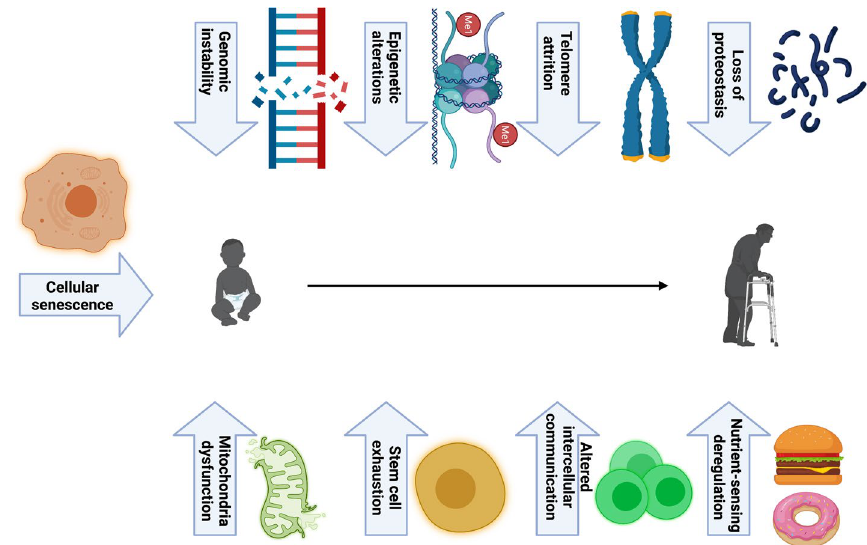
Fig. 1 Major contributors to aging machinery. The nine hallmarks of aging: DNA damage, telomere attrition, epigenetic alteration, loss of proteostasis, mitochondrial dysfunction, cellular senescence, nutrient sensing, intracellular communication, and stem cell exhaustion